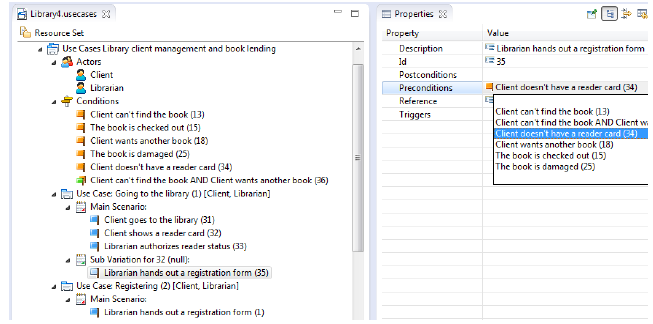
Fig. 3. Use Case Editor tool. This shows the use case model constructed by a user and properties view of a use case step, where it is possible to set preconditions.